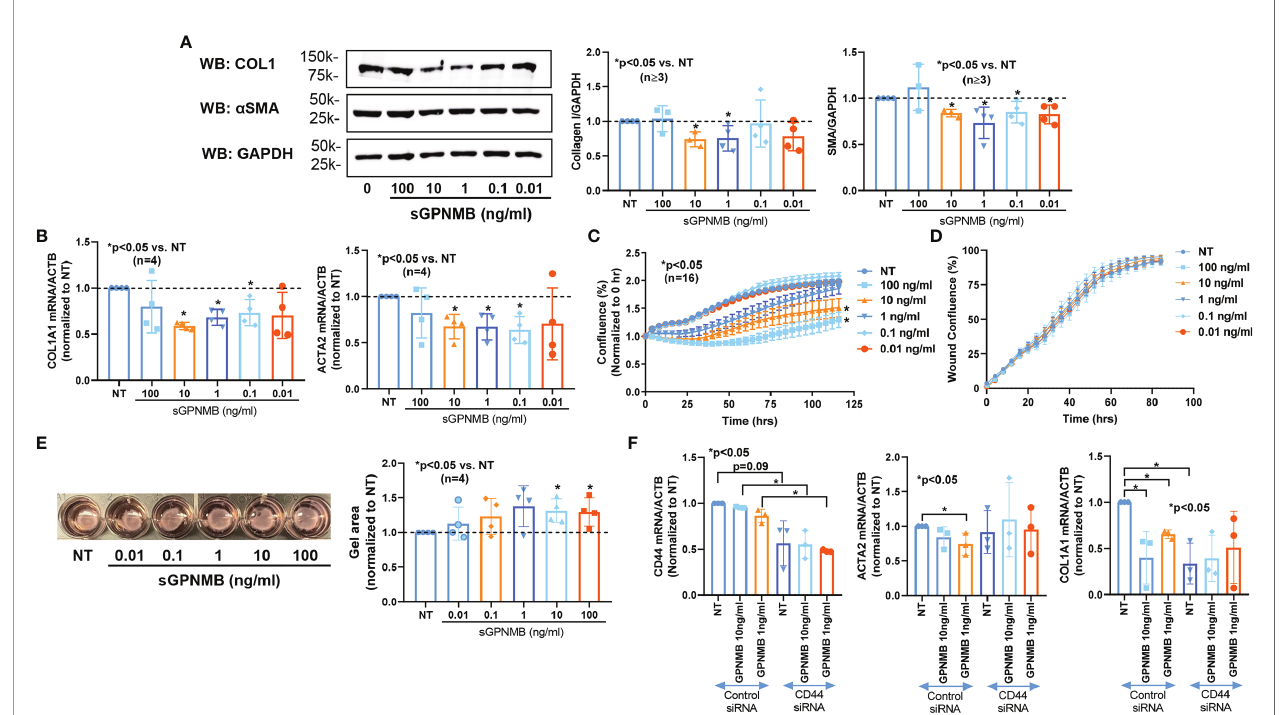
FIGURE 2 | sGPNMB inhibits SSc fi brosis in vitro . (A) sGPNMB signi fi cantly reduced COL1 and a SMA expression in dcSSc fi broblasts at various doses. (B) sGPNMB downregulated COL1A1 and ACTA2 at the mRNA level in dcSSc fi broblasts. (C) sGPNMB signi fi cantly reduced cell proliferation of dcSSc fi broblasts at a dose-dependent manner. Cell growth was monitored by IncuCyte ® Live-cell imaging. (D) Migration of dcSSc fi broblasts was not signi fi cantly affected by sGPNMB. Cell migration was monitored by IncuCyte ® Live-cell imaging. Wound con fl uence indicates the number of cells migrated into the wound gap. (E) Gel contraction by dcSSc fi broblasts was inhibited by sGPNMB at various doses. (F) The anti- fi brotic effect of sGPNMB was absent in CD44 knocked down dcSSc fi broblasts, as shown by COL1A1 and ACTA2 levels. n=number of subjects. Results are expressed as mean +/- SD and p < 0.05 was considered signi fi